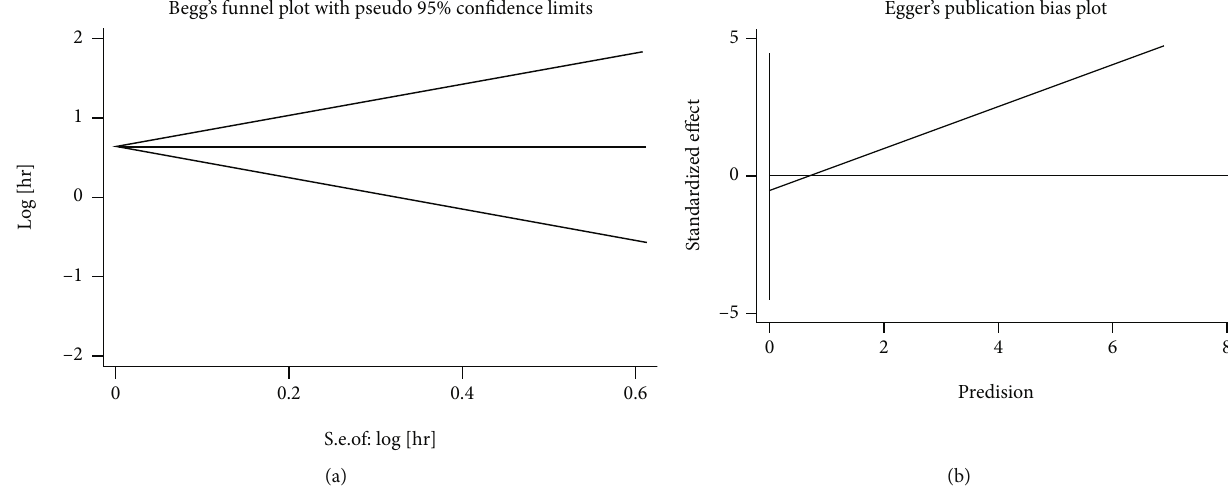
Figure 5: Publication bias. (a) Begg ’ s test for overall survival, p = 0 : 592 ; (b) Egger ’ s test for overall survival, p = 0 : 710